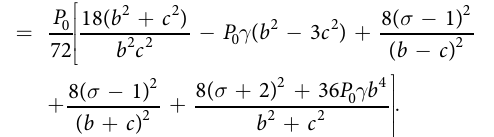
which reveals that the angular velocity ω is closely related to the OAM. Substituting the trial solution (3) into the −∞∞ −∞∞ Hamiltonian density (6) and carrying out integration ∫ ∫ = H hdxdy , we obtain the Hamiltonian of the system, which is the function of b , c , B , Q and Θ . As did in our previous work 9 , by the substitution of Eqs (8), (9) and (10), the Hamiltonian is expressed by H ( b ′ , c ′ , b . c ), which is the summation of the generalized kinetic energy T and the generalized potential energy V . The generalized kinetic energy T is a quadratic function of the general- ized velocity b ′ and c ′ . If we assume that T = 0, i.e. b ′ = c ′ = 0, we can obtain the potential energy V = H ( b , c ) as follows